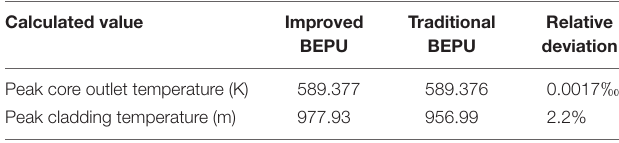
TABLE 5 | Comparison with improved BEPU and traditional BEPU